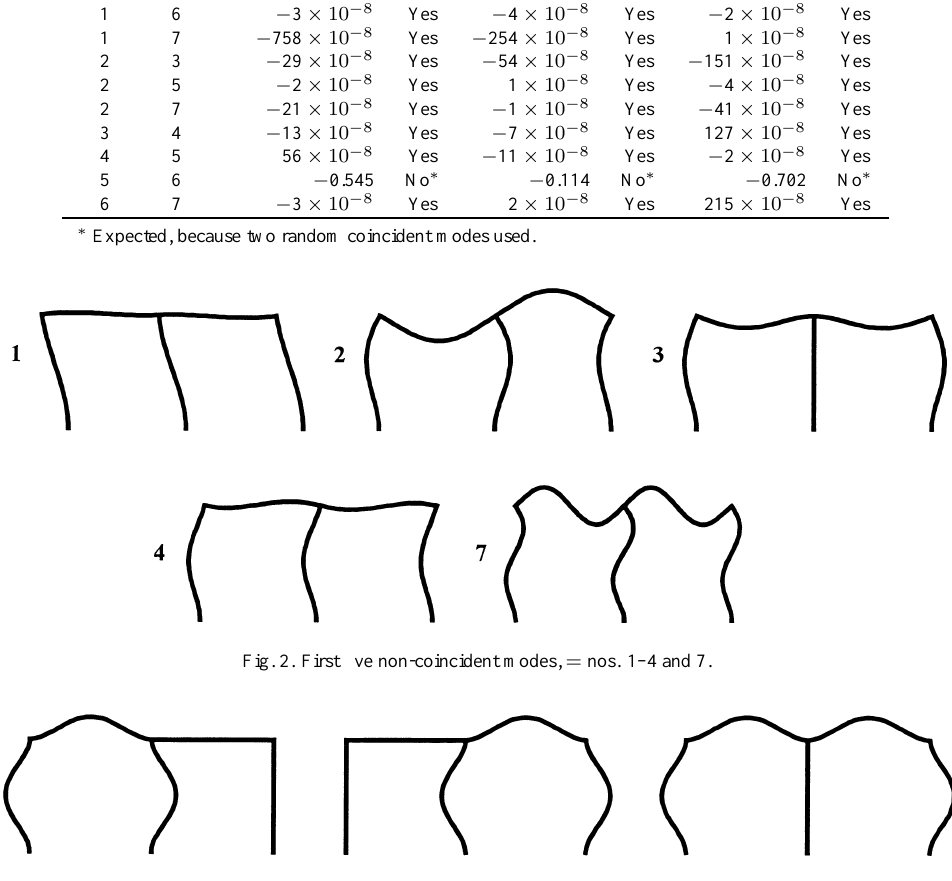
Fig. 3. Possible (non-orthogonal) choices for the coincident fifth and sixth